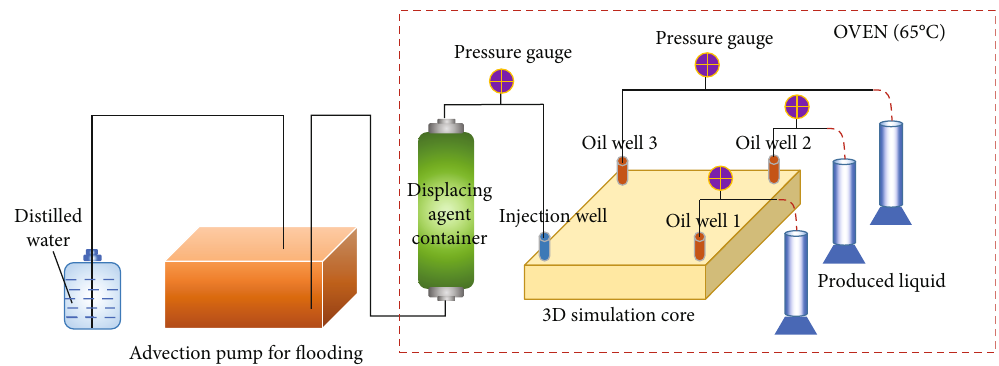
Figure 1: Schematic diagram of experimental